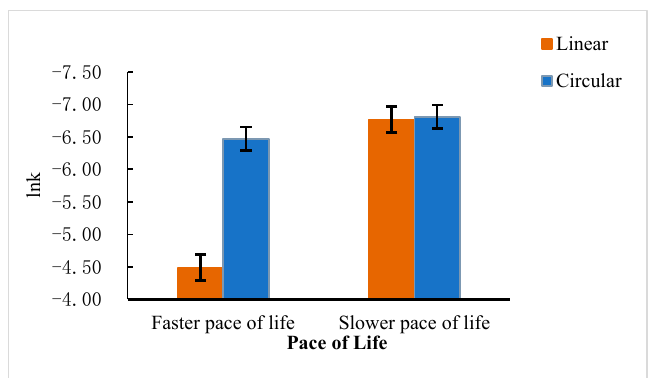
Figure 2. Comparison of participants’ intertemporal decision scores (lnK) under different paces of life and different views of times. Table 2. Intertemporal decision scores (lnK) for participants with different paces of life under dif- ferent views of time conditions ( M ± SD ).